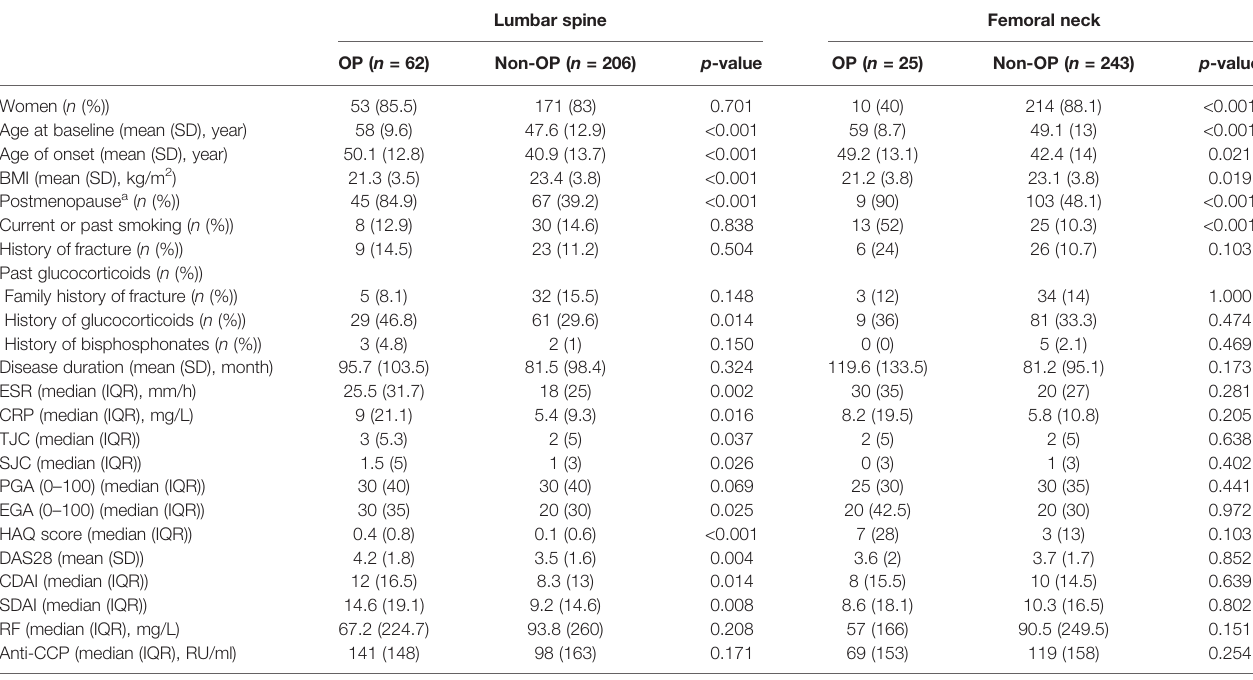
TABLE 2 | Comparisons between RA patients with OP and without OP at baseline.